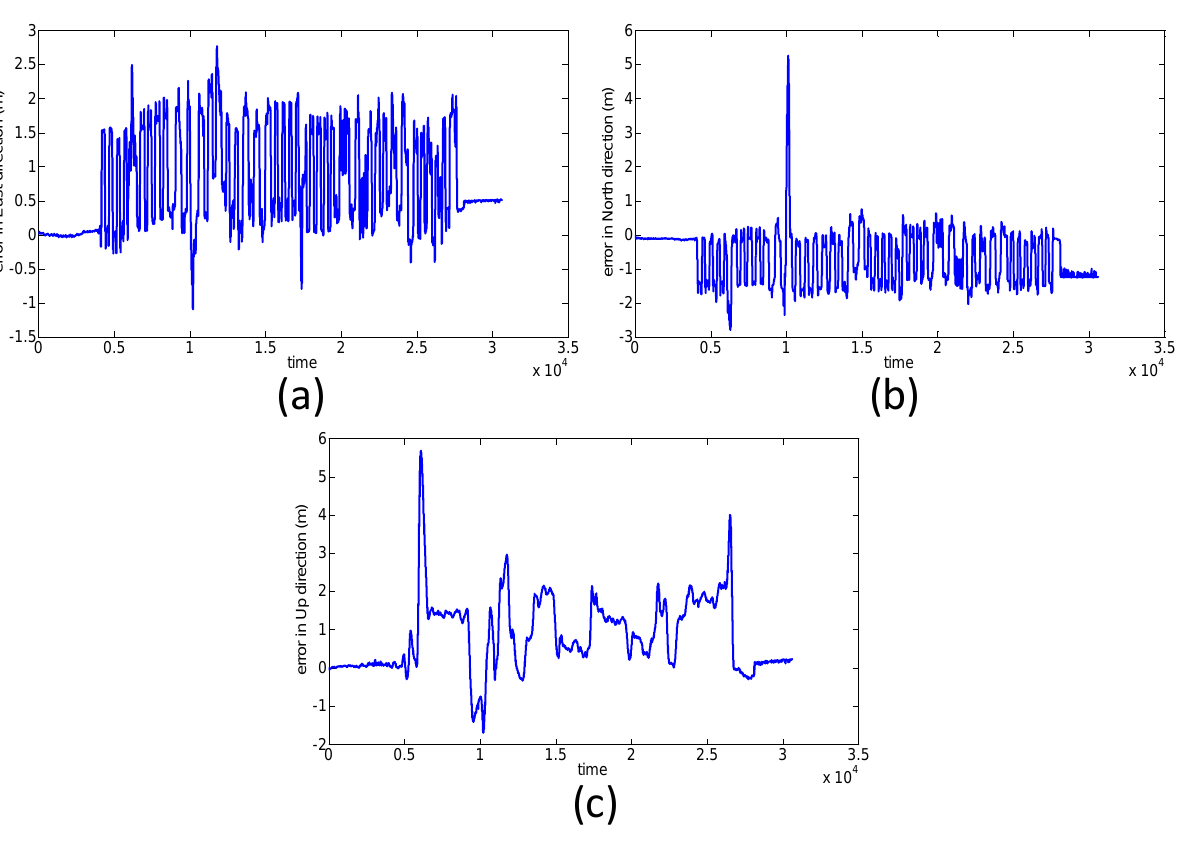
Figure 18. ( a ) Roll; ( b ) Pitch; ( c ) Heading angle